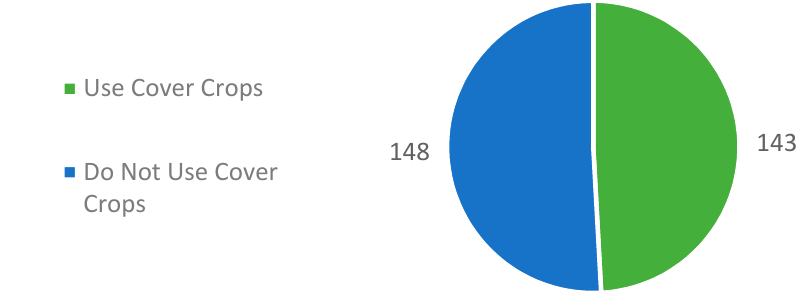
Figure 1. Count of Farmers by Cover Crop Use.